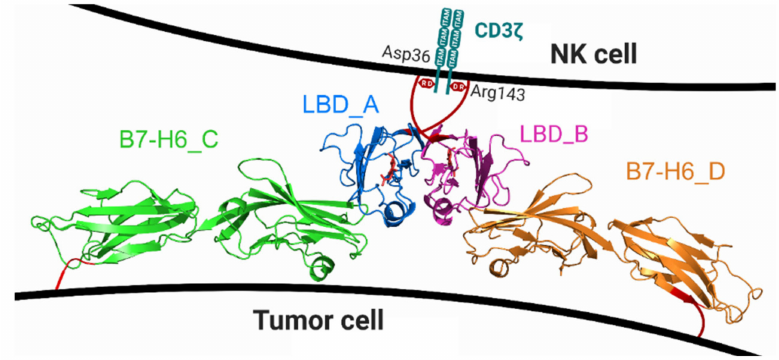
Figure 11. Model of the possible position of the NKp30_LBD:B7-H6 dimeric complex, as observed in the crystal structure (PDB 6YJP), within the NK cell immune synapse. B7-H6 has a very short stalk